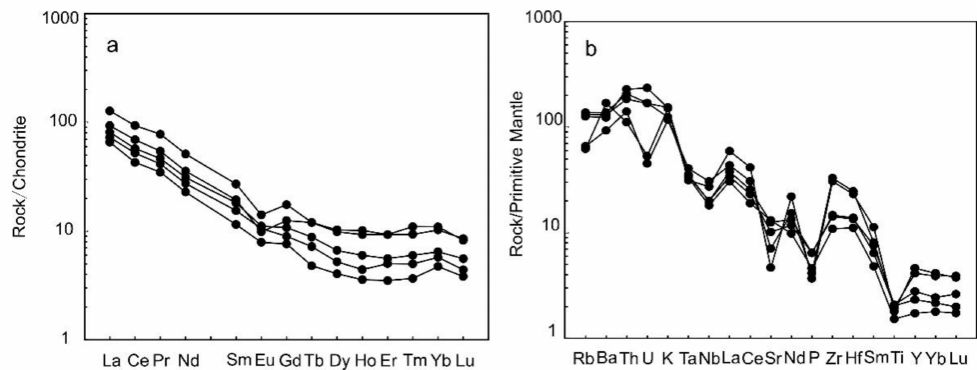
Figure 6. ( a ) Chondrite-normalized REE patterns and ( b ) primitive mantle (PM) normalized trace elements diagrams of the granite porphyry from Qinglingou. The values of chondrite and PM are from [33,34].